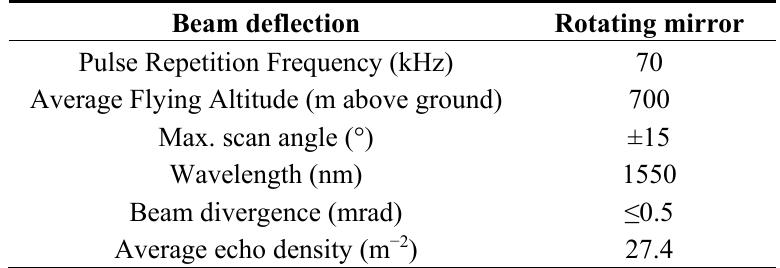
Table 2. Specifications of the LiDAR data acquired in September, 2010, with a Riegl LMS Q 560 laser scanning